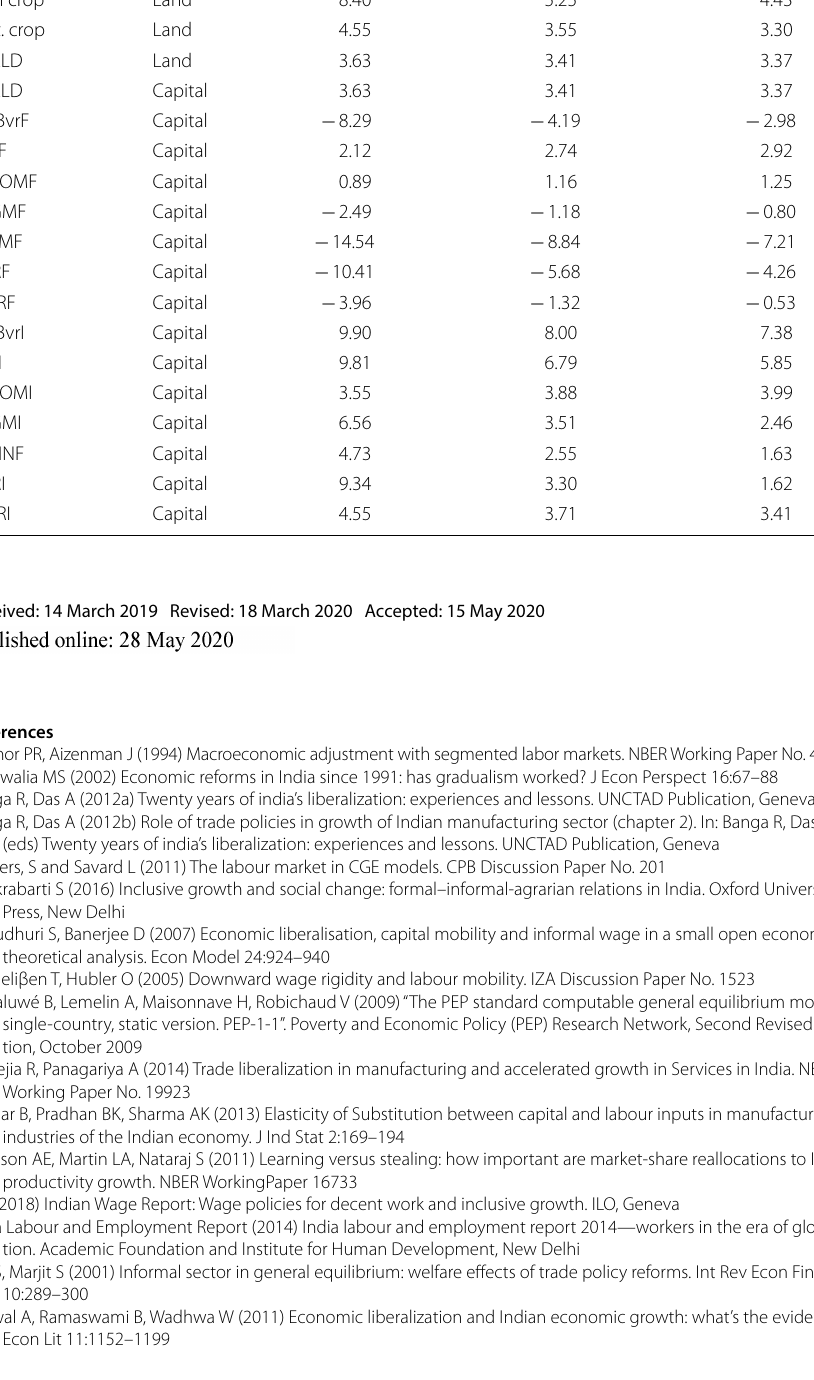
Segmented labour market-2 = 0.2 σ LD j